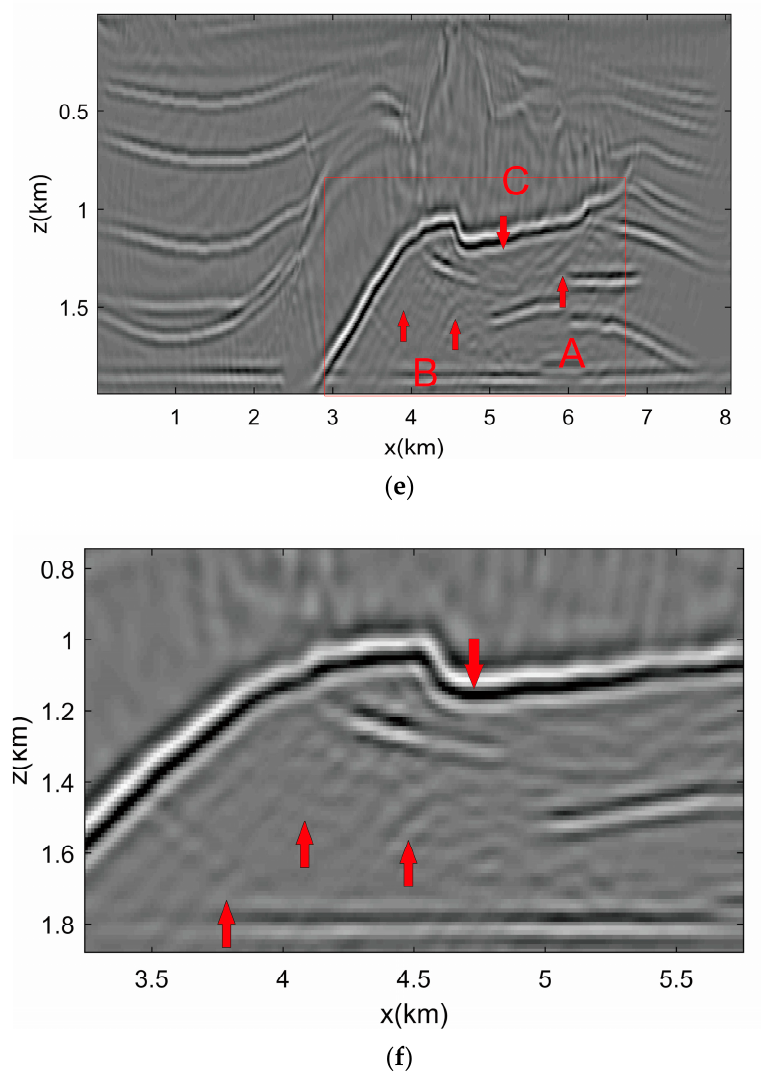
Figure 8. ( a ) LSRTM image. ( b ) Close ‐ up section of LSRTM image. ( c ) RWLSRTM image of the primary. ( d ) Close ‐ up section of RWLSRTM image of the primary. ( e ) RWLSRTM image of the primary and internal multiples. ( f ) Close ‐ up section of RWLSRTM image of the primary and internal multiples.